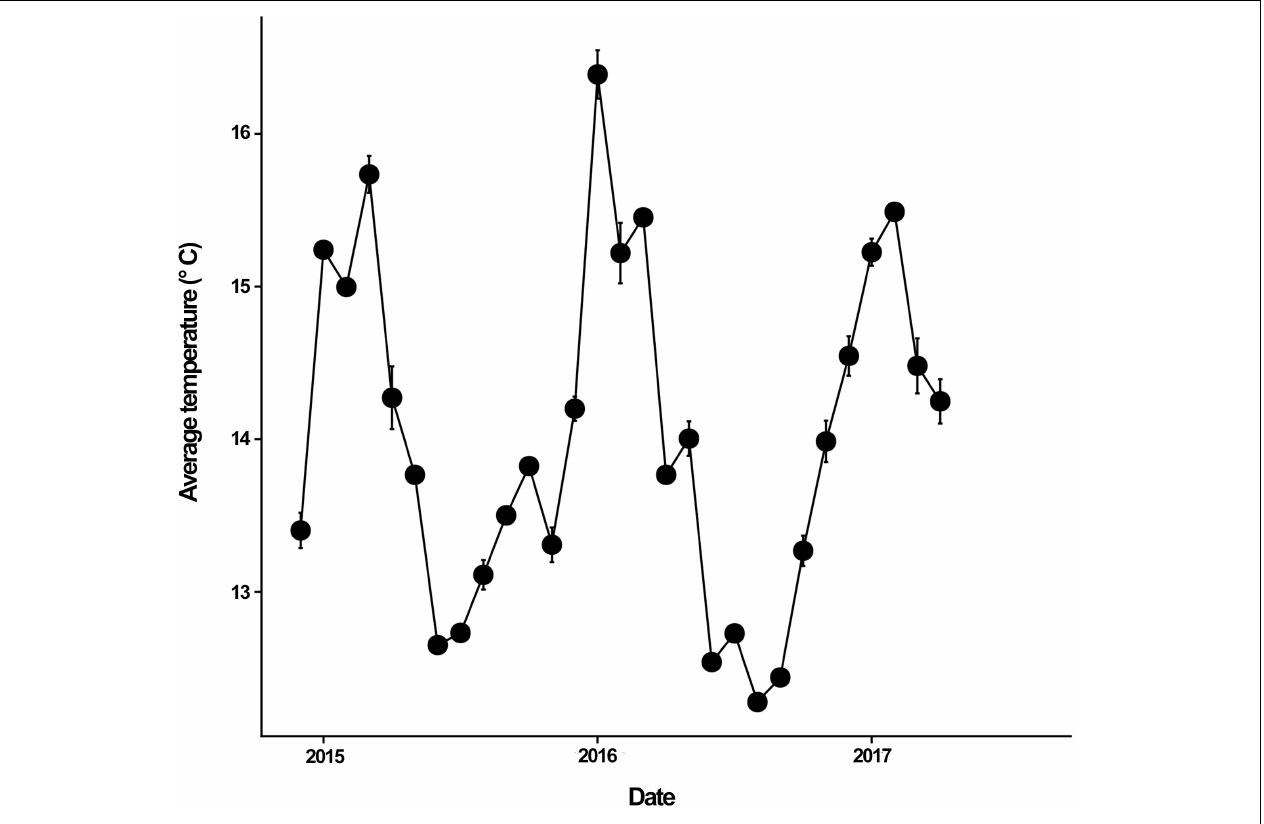
FIGURE 3 | Temporal variation in mean ( ± SE) sea surface temperature in the experimental sites used in our study. For temperature, we considered monthly averaged temperature of both sites, Limarí and Punta de Talca. Each year label is positioned in January of each year (early summer in southern